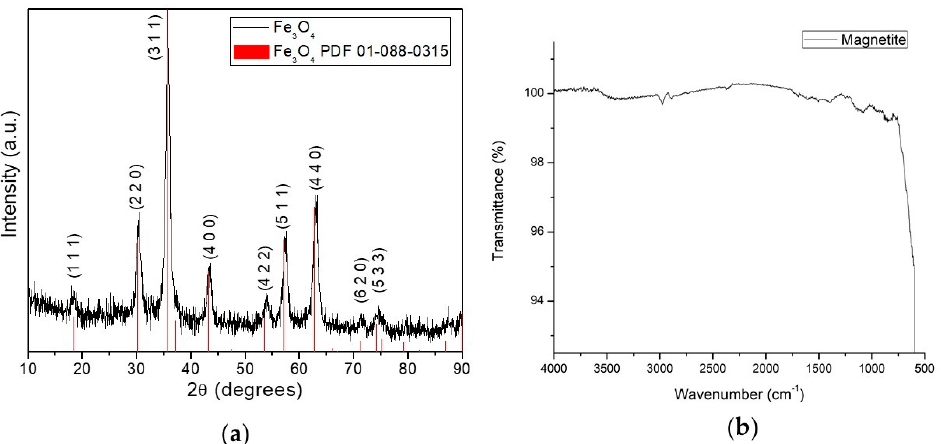
Figure 2. Magnetic nanoparticles (MNPs) synthesis characterization. ( a ) XRD pattern from magnetite nanoparticles exhibits nine di ff raction peaks observed at 2 θ value 18.29, 30.13, 35.61, 43.26, 53.84, 57.32, 63.13, 71.15 and 74.17, which match with the reference PDF 01-088-0315 card. Those peaks are indexed to the (1 1 1), (2 2 0), (3 1 1), (4 0 0), (4 2 2), (5 1 1), (4 4 0), (6 2 0) and (5 3 1) planes respectively; ( b ) FTIR spectra of bare magnetite. Magnetite shows the first band around 600 cm − 1 . It is related to Fe–O stretching in the octahedral site of the crystal structure of magnetite.